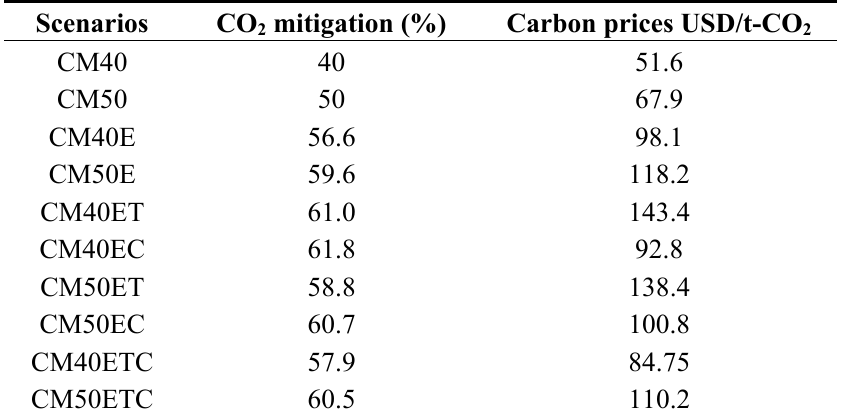
Table 4. Carbon prices and the corresponding CO 2